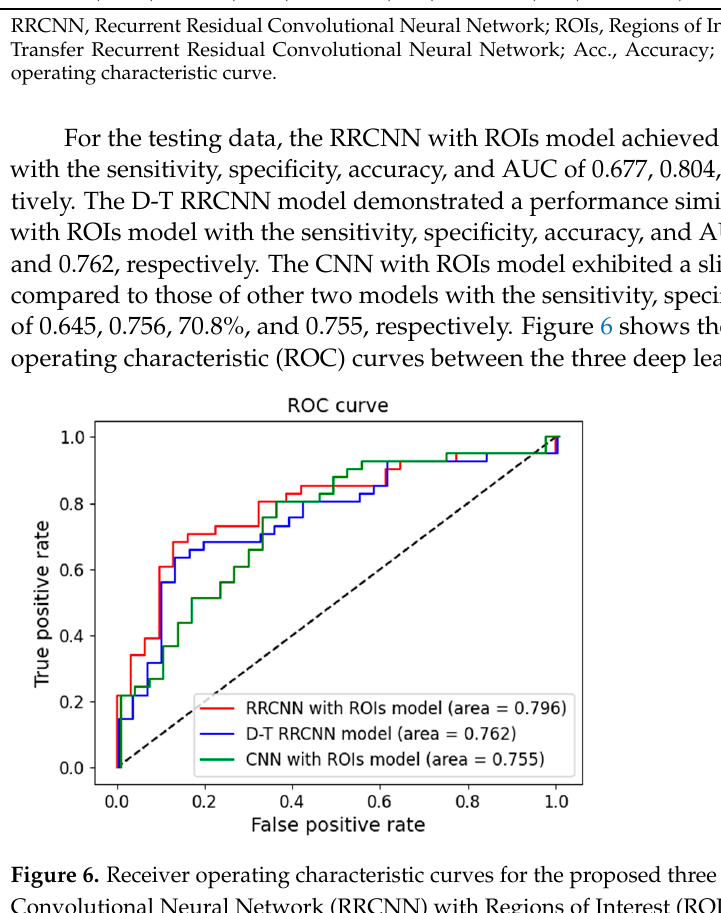
Table 3. Comparison of performance between the three deep learning models. The 95% confidence intervals are listed in parentheses.